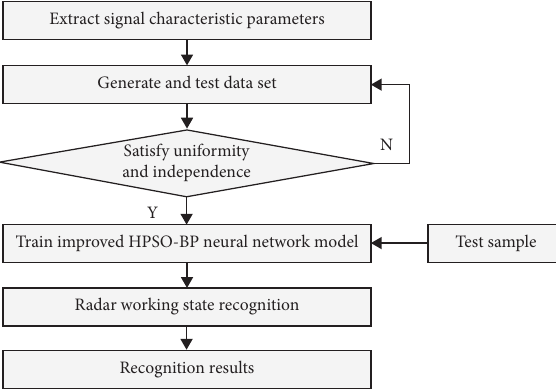
Figure 1: Structure of radar working state recognition model based on improved